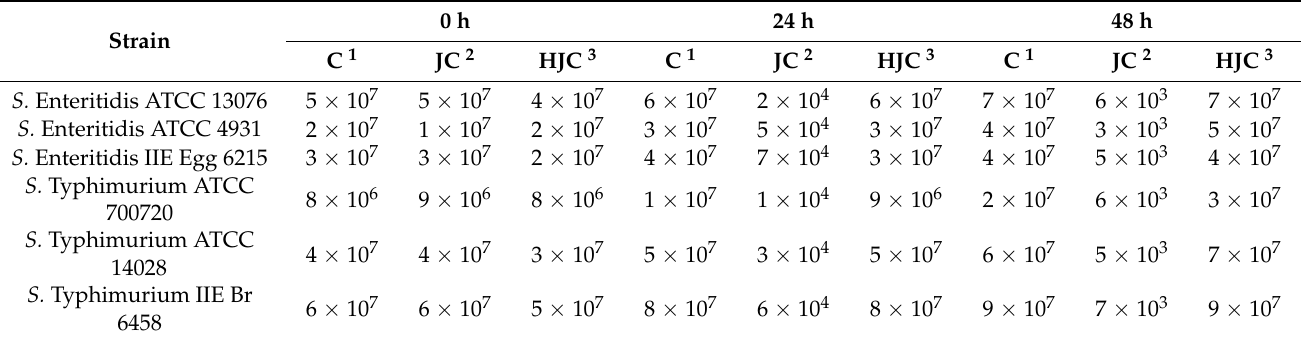
Table 4. Antagonistic activity of LF3872 against Salmonella strains.